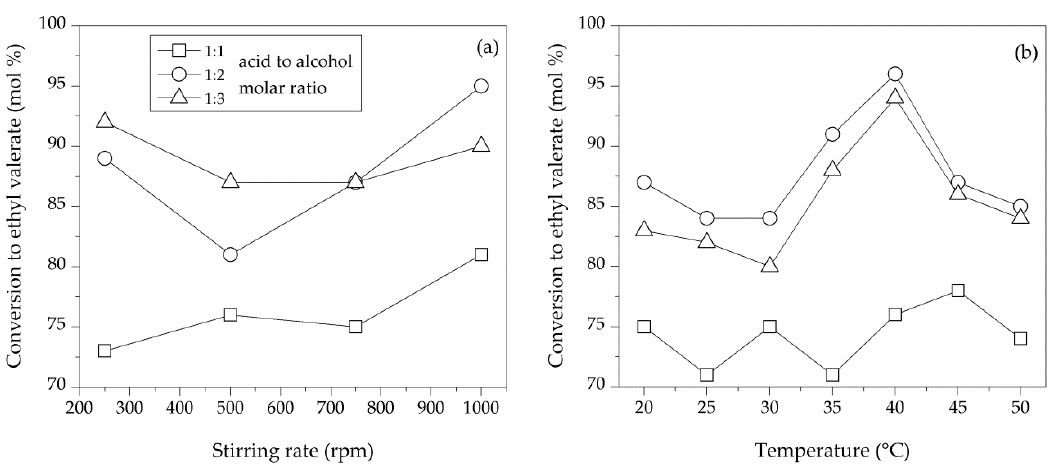
Figure 4. Effect of ( a ) stirring rate and ( b ) reaction temperature on the conversion of valeric acid to ethyl valerate by CH procedures.